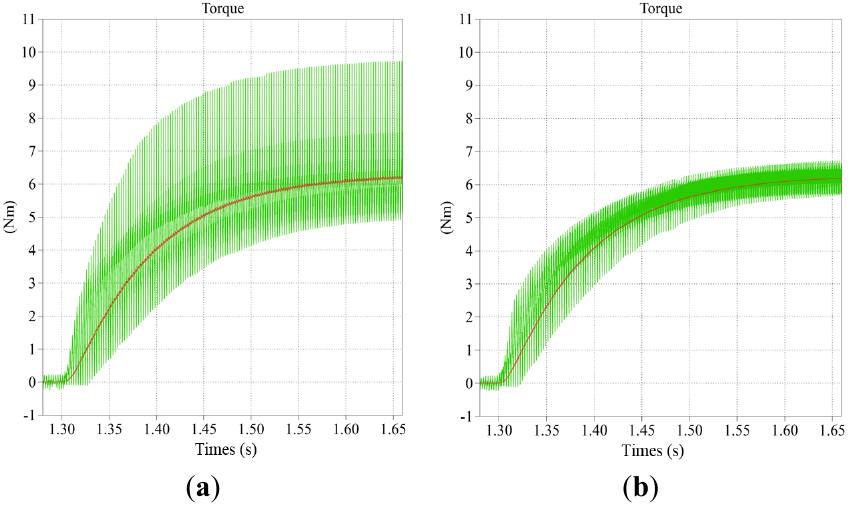
Figure 13. Torque control according to the variable torque: ( a ) asymmetric TSF; ( b ) non-unity TSF.